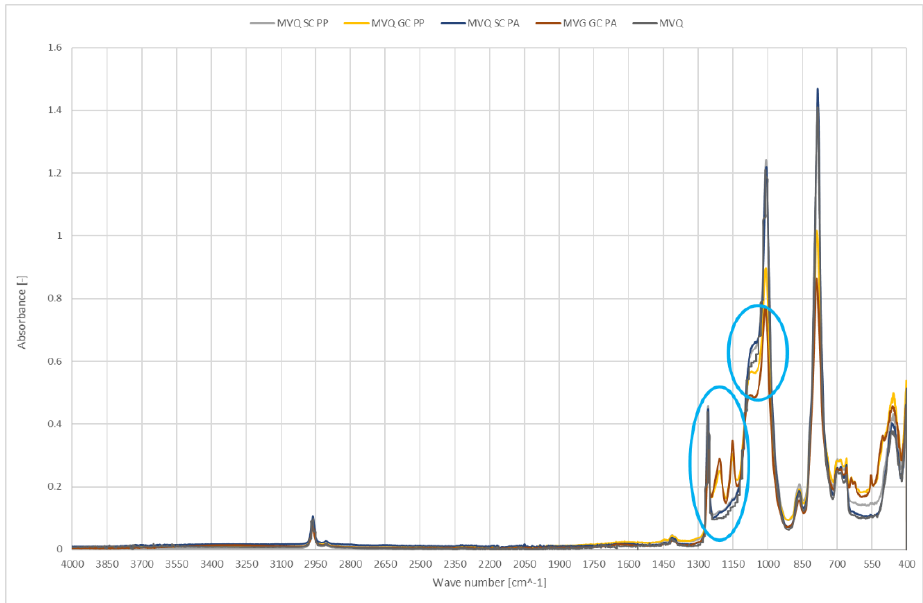
Figure 5. IR spectra of polymer materials made of silicone rubber (SC — chemically modified smooth samples, GC — chemically modified geometrised samples subjected to plasma modification in the air (PP) or argon (PA), and for non-modified polymer material made of silicone rubber).